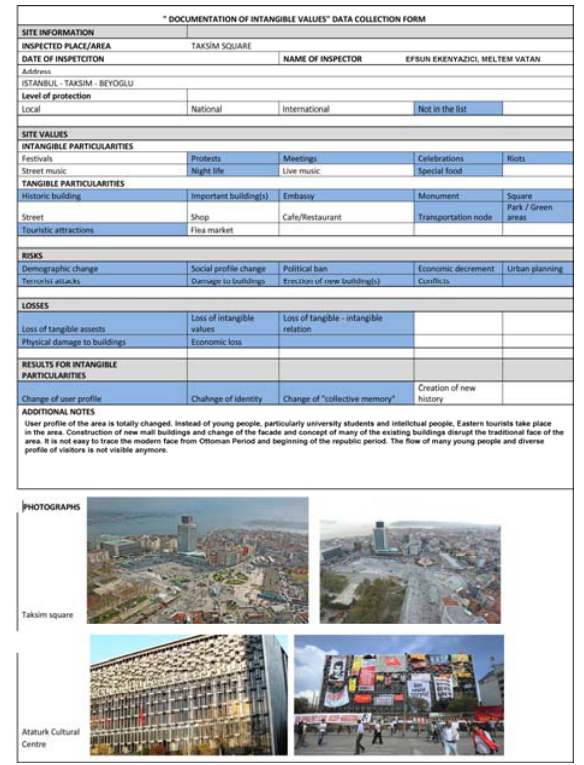
Figure 10: Collected data of Taksim Square When when we look at the changes that have happened in Kensington Market over the recent years, even though the changes are not as drastic as it is in the case of Taksim Square, it does create a risk in terms of the preservation of the heritage fabric. The slower change that is happening due to changing demographics and user profiles are altering the streetscapes. As mentioned before, as the new demographic groups enter and “occupy” the neighbourhood, the patina of the previous user groups are being erased. The changing tangible environment results or will eventually result in the erasure or alteration of “collective memory”.